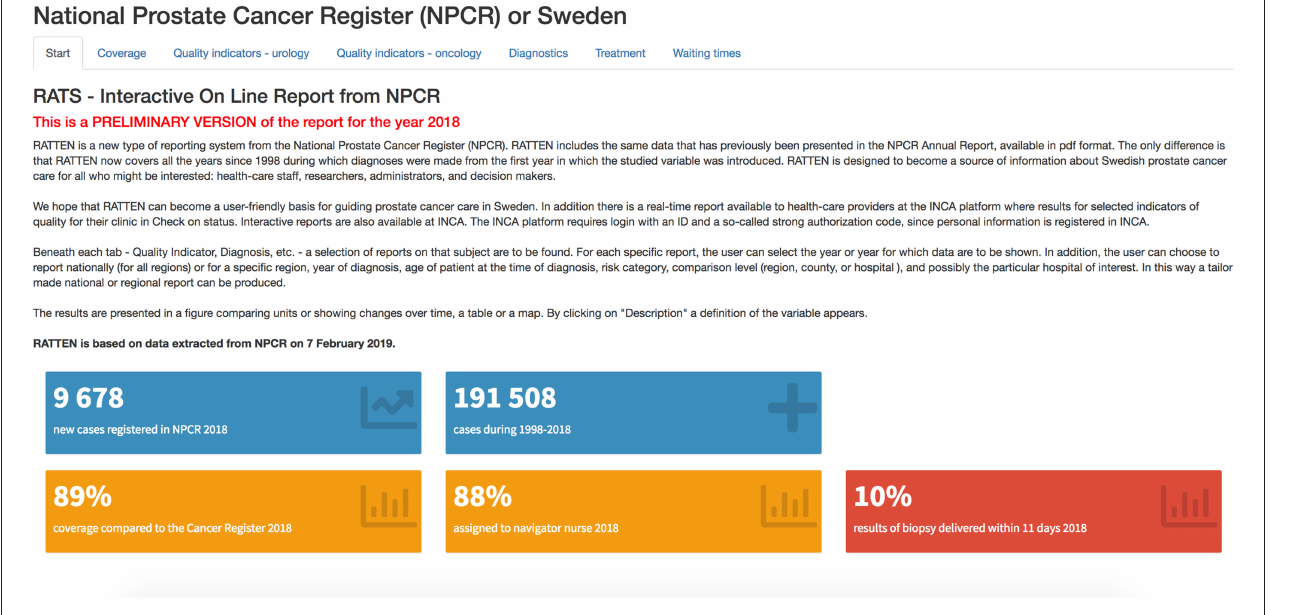
FIGURE 1 | Screenshot of RATTEN, a reader-friendly format for accessing information in NPCR (preliminary data for 2018).